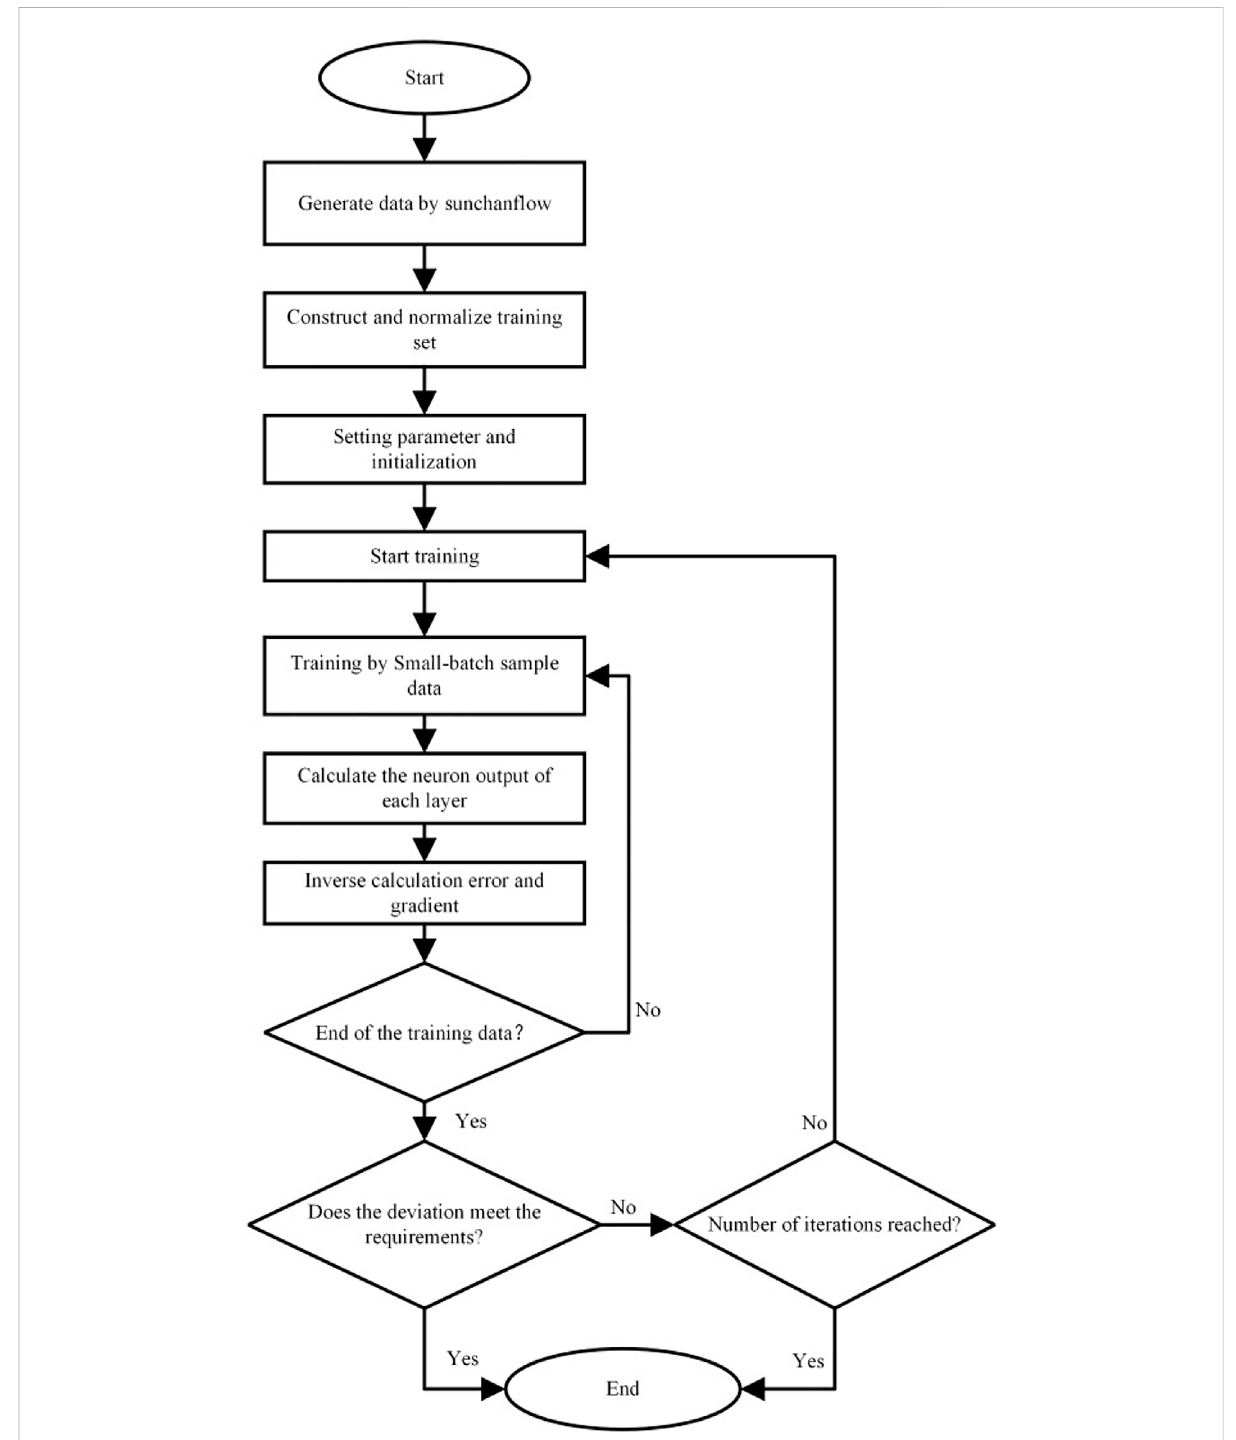
FIGURE 2 Flow-process diagram of neural network forecast